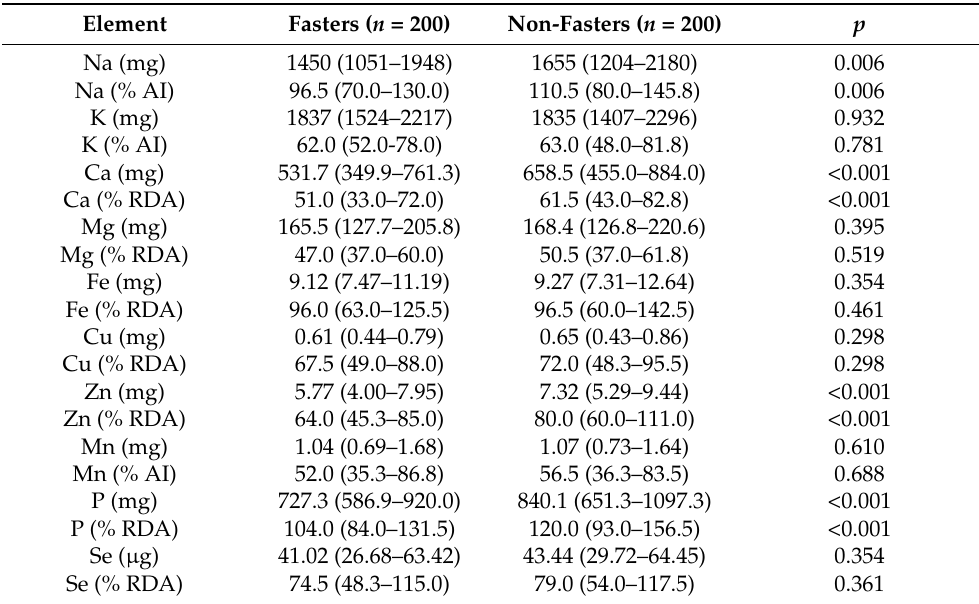
Table 3. Daily element intakes by the two groups, based on three-day dietary records (median and interquartile